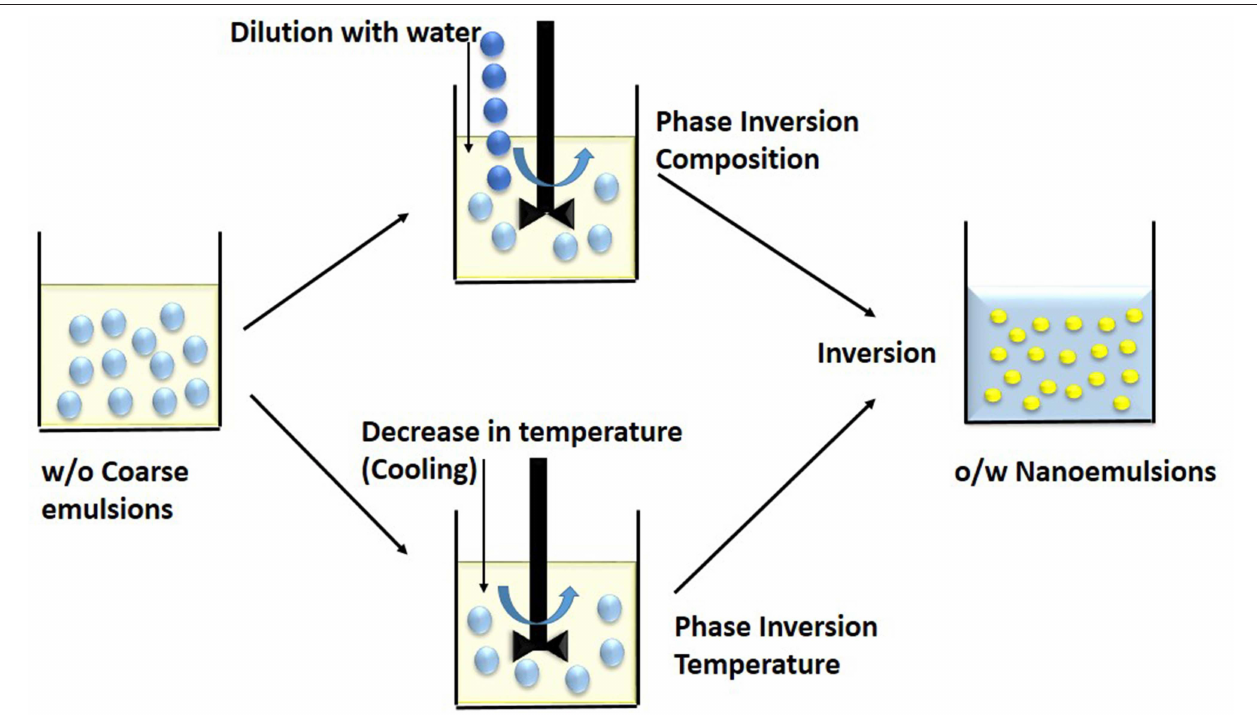
FIGURE 3 | Low energy methods involves breakdown of coarse w/o macroemulsions into nanoemulsions during phase inversion. In the Phase Inversion Composition technique, dilution by water induces a phase inversion while in the Phase Inversion Temperature method, cooling or decrease in temperature induces a phase